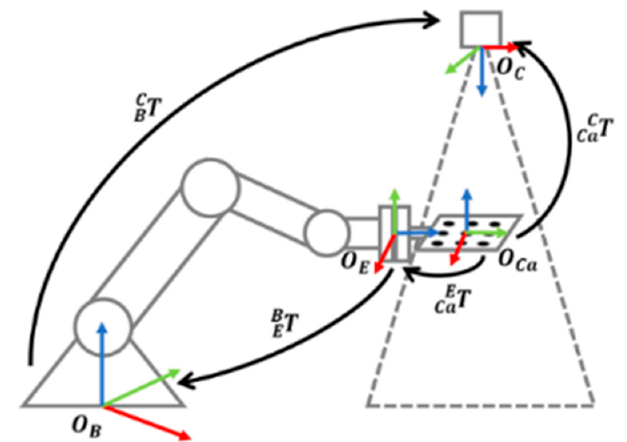
Figure 5. The principle of hand-eye calibration.